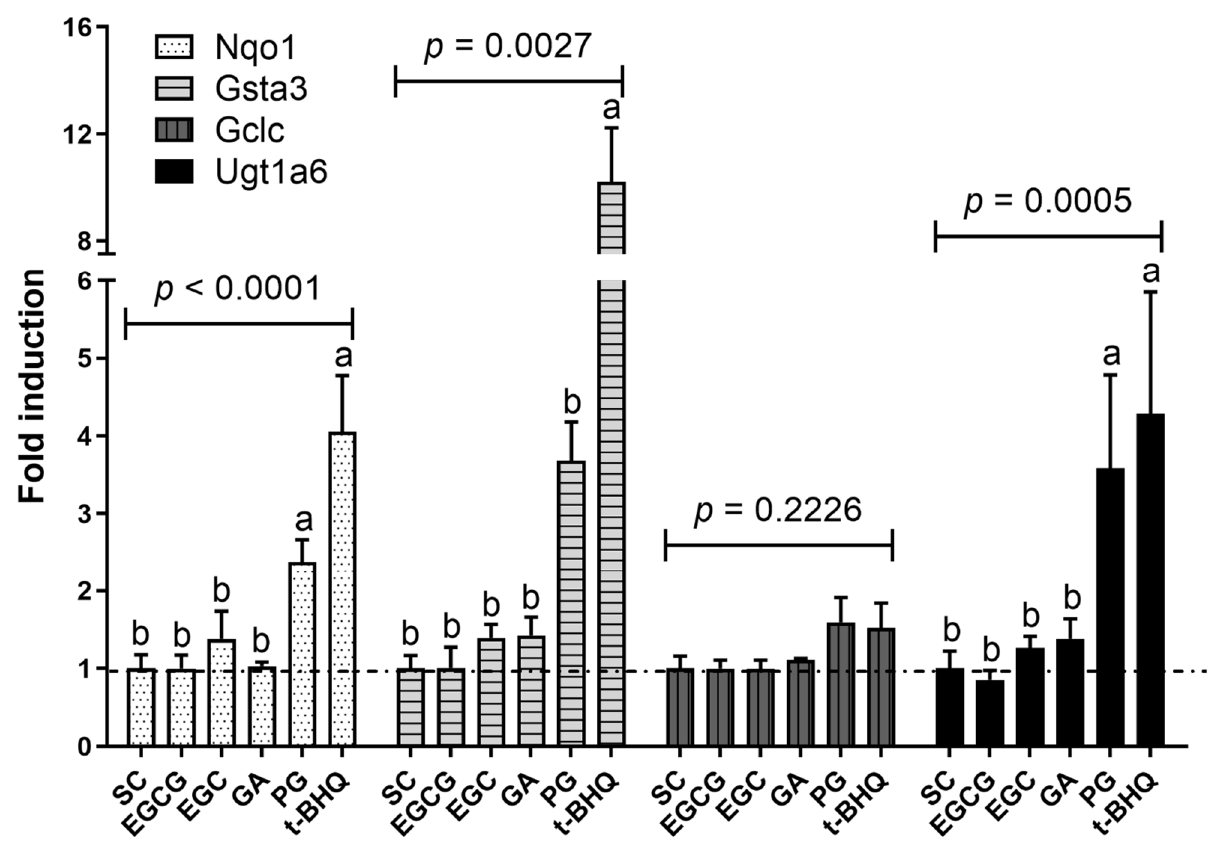
Figure 6. Relative RNA levels in Hepa1c1c7 cells after exposure to the selected model compounds at 30 µ M. The results were calculated relative to solvent control (SC) and are presented as mean ± SEM, derived from four independent experiments. One-way ANOVA with Newman–Keuls post-test was performed. Group means not sharing a common superscript are different from each other ( p < 0.05). Results derived from four independent experiments. EGCG, ( − )-epigallocatechin gallate; EGC, ( − )- epigallocatechin; GA, gallic acid; PG, pyrogallol; t-BHQ, tert-butylhydroquinone; Nqo1, NAD(P)H dehydrogenase (quinone) 1; Gsta3, Glutathione s-transferase A3; Gclc, Glutamate-cysteine ligase catalytic subunit; Ugt1a6, UDP glucuronosyltransferase family 1 member